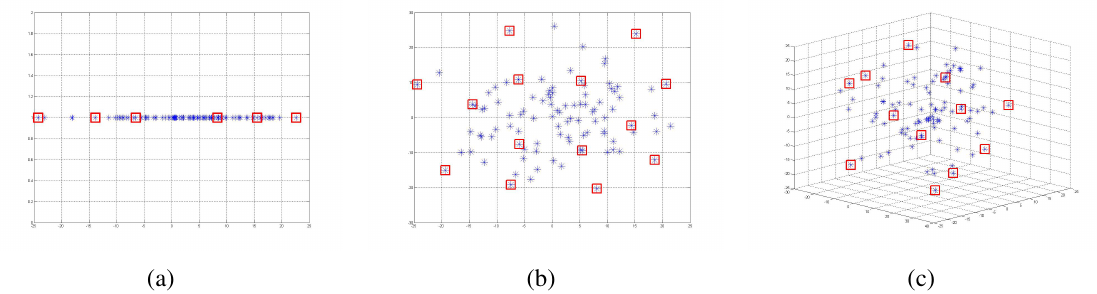
Figure 4: Result on synthetic dataset. Stars are the 3D samples and squares are the distinct patterns we found. (a) result for 1D dataset, (b) result for 2D dataset, (c) result for 3D